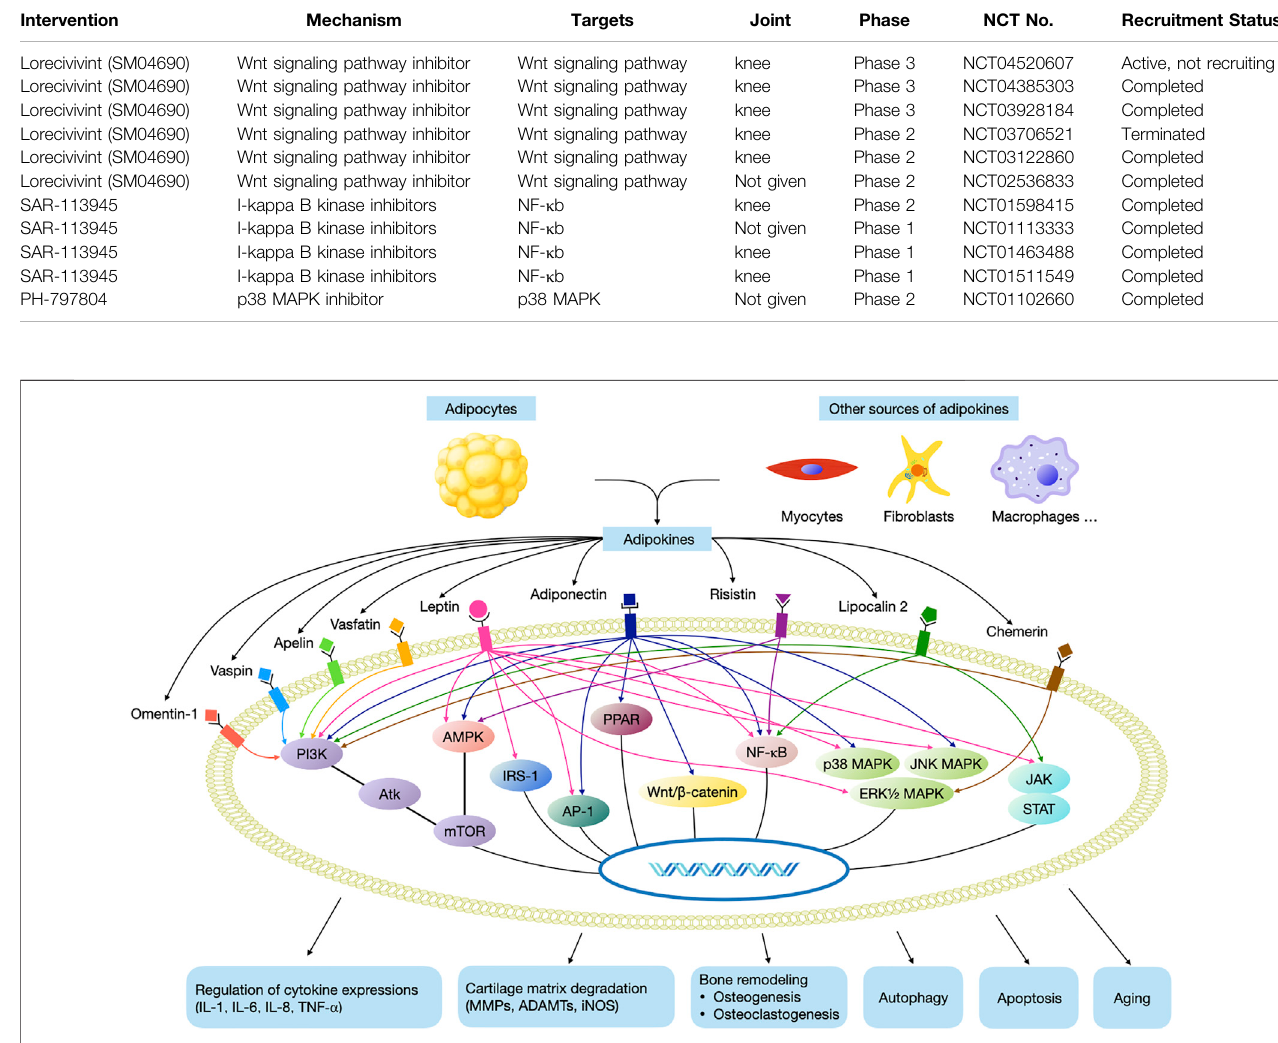
FIGURE 2 | Main adipokine signaling pathways in OA. (AMPK, AMP-activated protein kinase; mTOR, mammalian target of rapamycin; NF- κ B, nuclear factor- κ B, JAK, janus kinases; STAT, signal transducer and activator of transcription, MAPK, mitogen activated phosphokinase; AP-1, activating protein-1; IRS-1, insulin